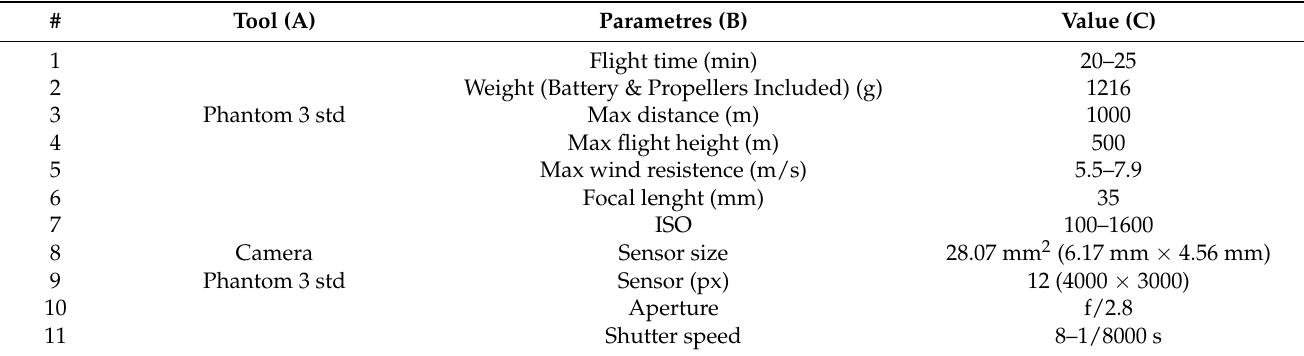
Table 1. Features of the Phantom 3 Standard and its